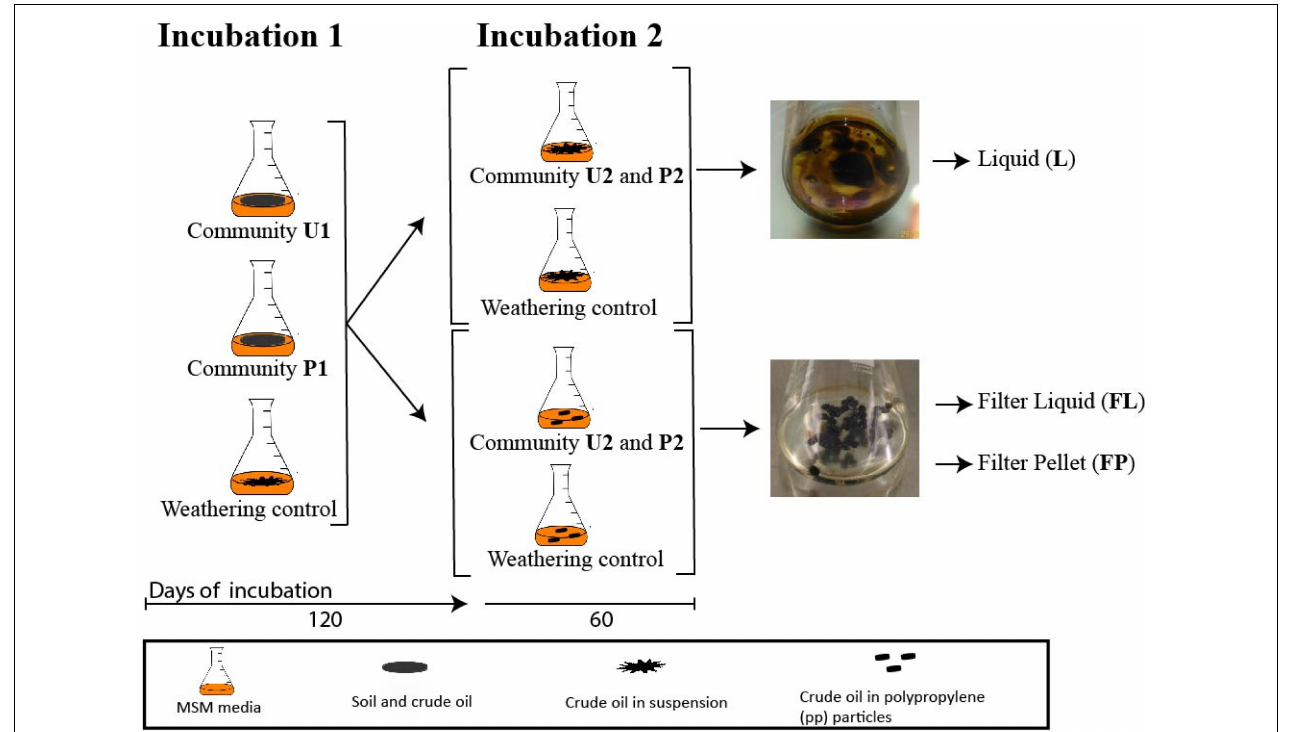
FIGURE 1 | Schematic representation of the experimental